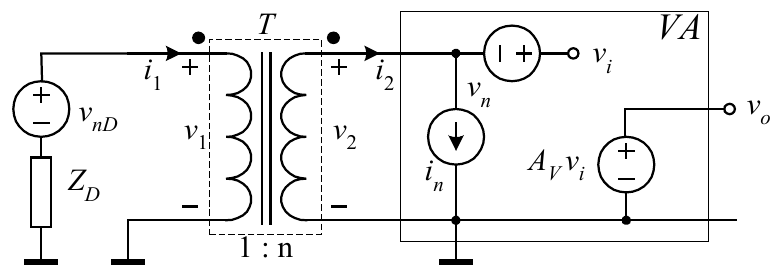
Figure 1. Simplified schematic of a transformer-coupled amplifier. VA is a voltage amplifier based on FET input operational amplifier with a constant gain A V and very large input impedance.